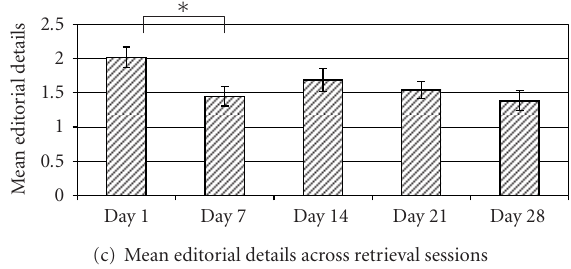
Figure 2: Behavioral measures for multiple retrieval memories across retrieval sessions. Mean word count (a) and mean total detail count (b) significantly increased across the first three retrieval ses- sions and was maintained across the final three retrieval sessions. Mean editorial detail count (c) for the multiple retrieval condition decreased significantly between Day 1 and each subsequent retrieval